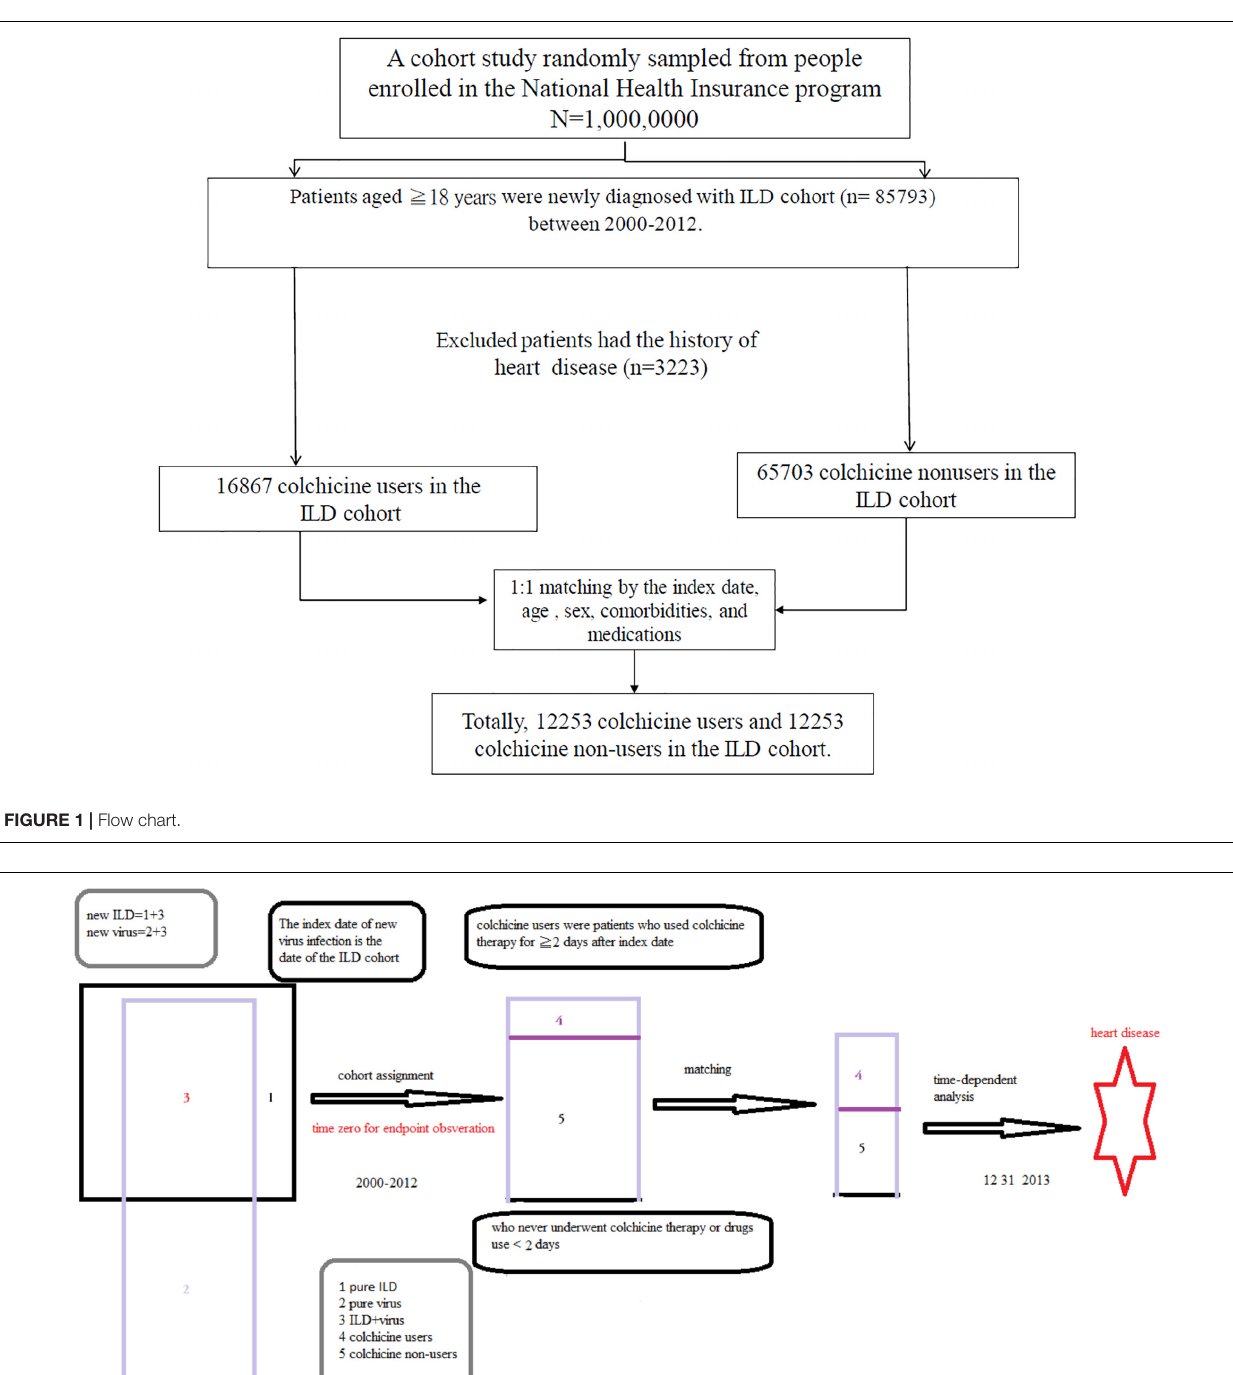
FIGURE 2 | The selection of patients and definition of the study cohort and speculation of this study.